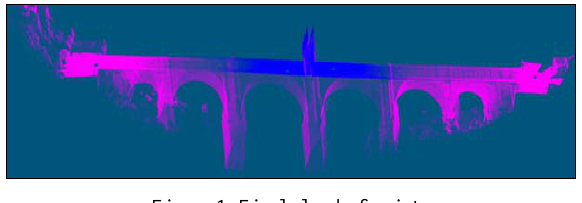
Figure 1. Final cloud of points.